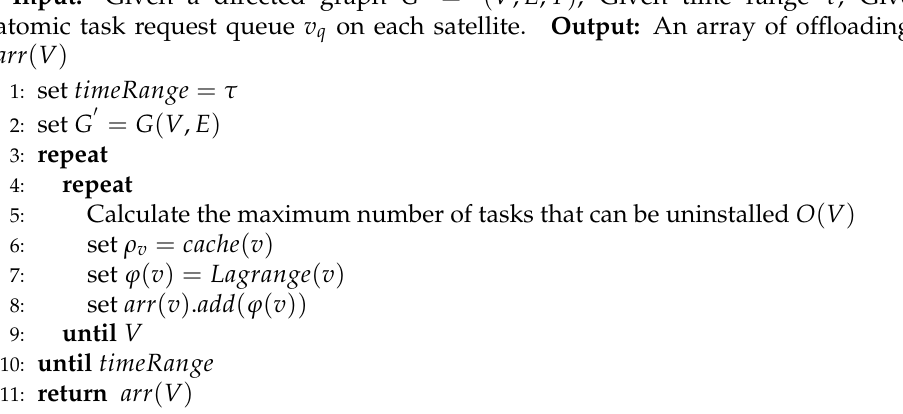
Algorithm 2 Satellite mission offloading optimization